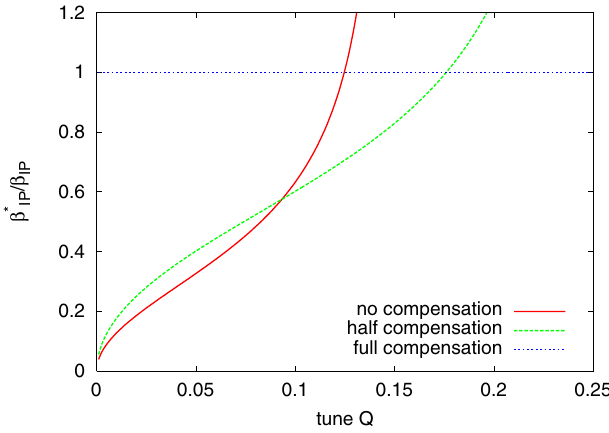
FIG. 2. (Color) Dynamic (cid:1) functions at the IP, for full ( N e ¼ N ¼ 0 : 5 (cid:1) N N ¼ 0 ) beam-beam com- N p ), half ( e p ), and no ( e pensation, for a beam-beam parameter (cid:2) ¼ 0 : 32 , corresponding to N p ¼ 4 (cid:3) 10 11 .